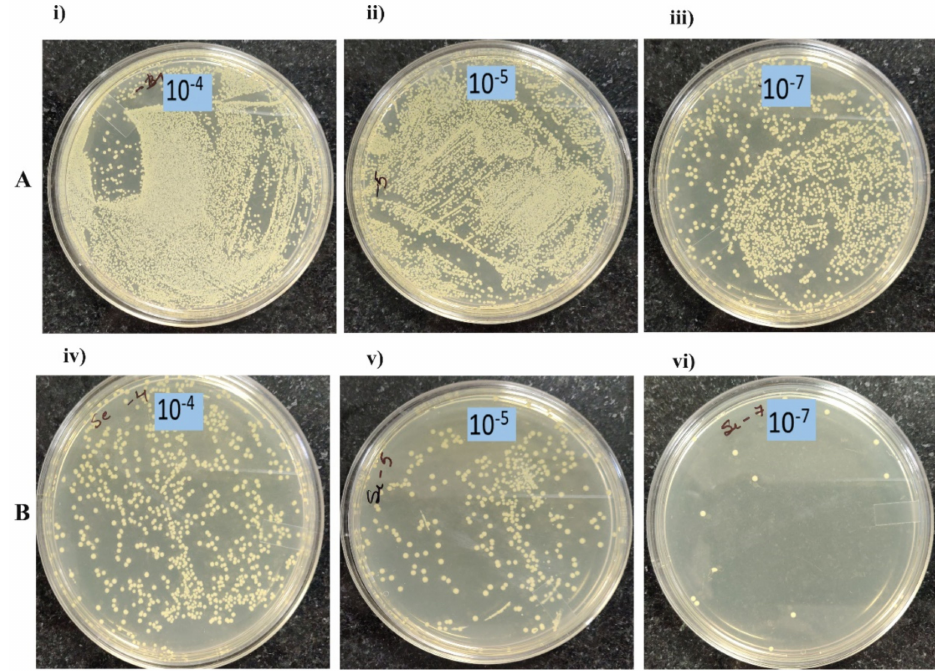
Figure 4. The viability of S. aureus bacterial cells with rGO-S/Se 200 µ g/mL NPs after 8 h incubation. Photographs of S. aureus ( A ) without NPs and ( B ) with NPs of rGO-S/Se, at (i), (iv) 10 − 4 ; (ii), (v) 10 − 5 ; and (iii), (vi) 10 − 7